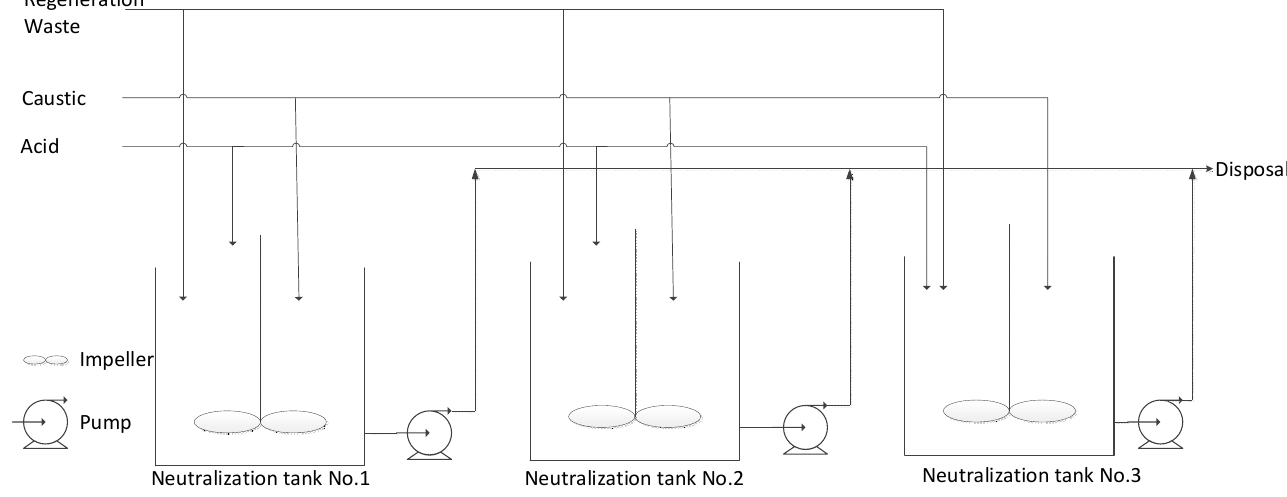
Figure 1. First neutralization process. Neutralization is done in three tanks in parallel in batch mode.